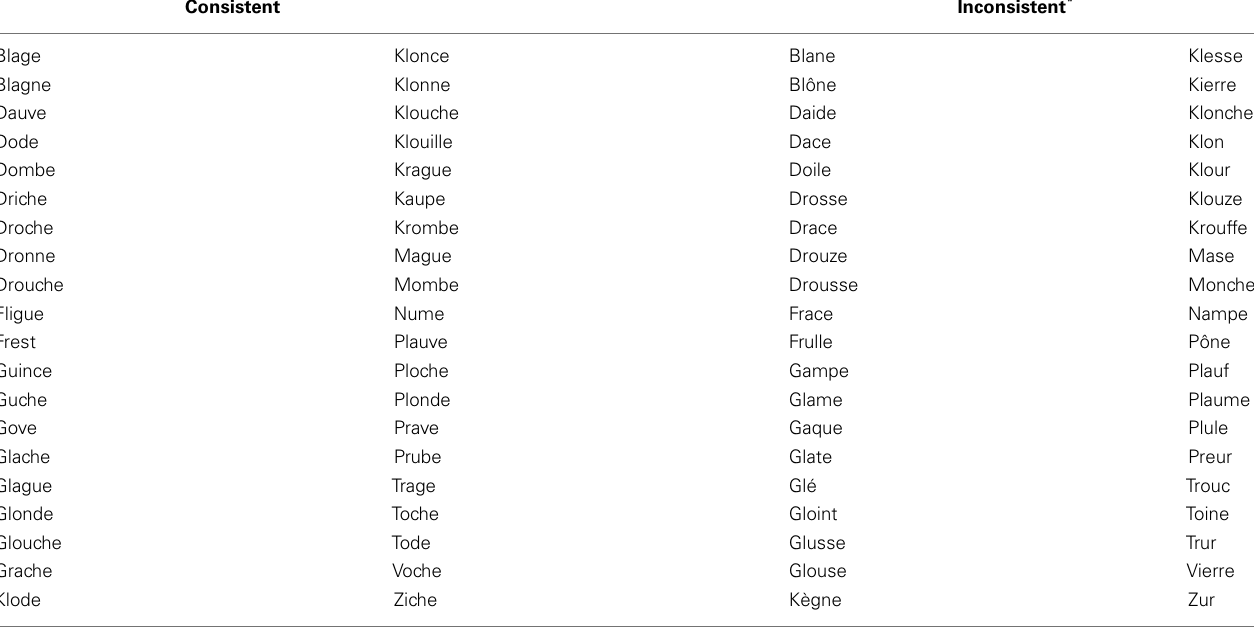
TableA2 | Pseudoword